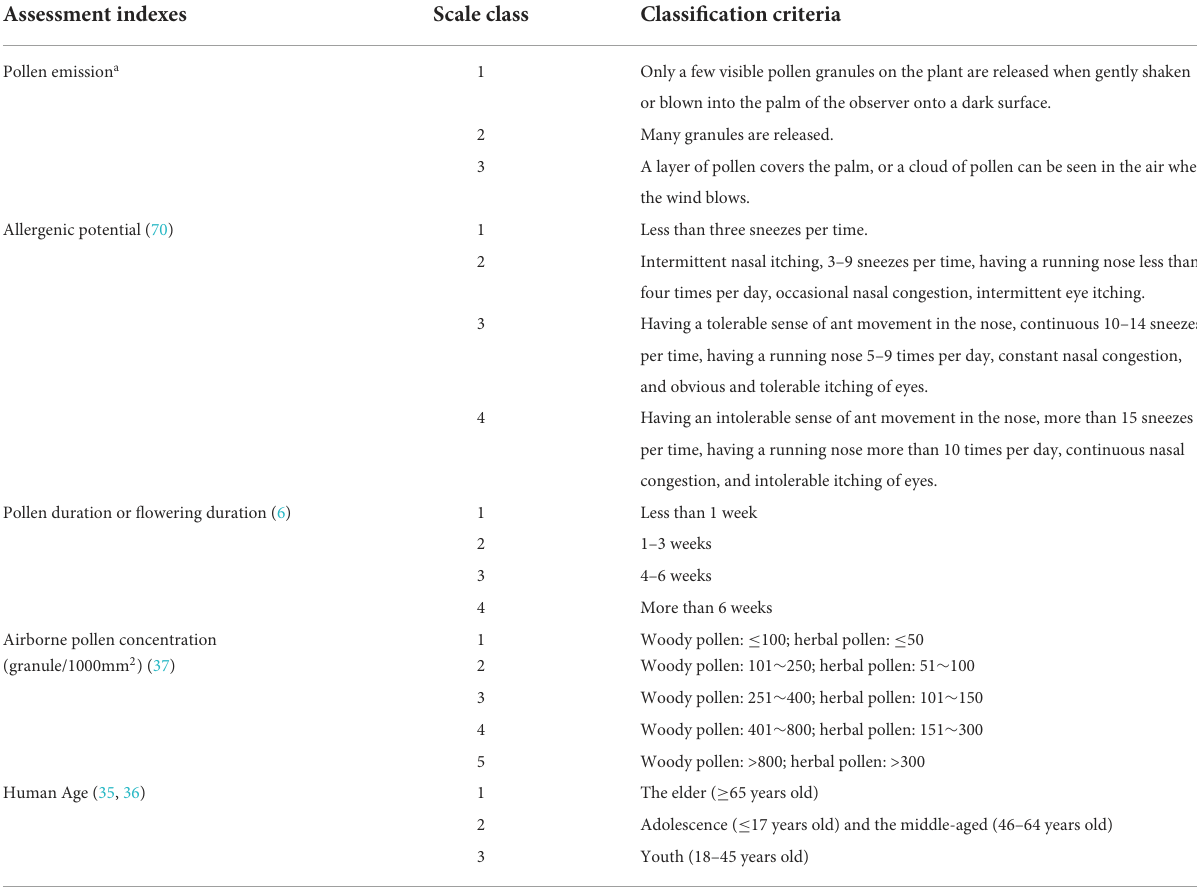
TABLE 1 Classification criteria of specific indexes for pollen allergy risk.